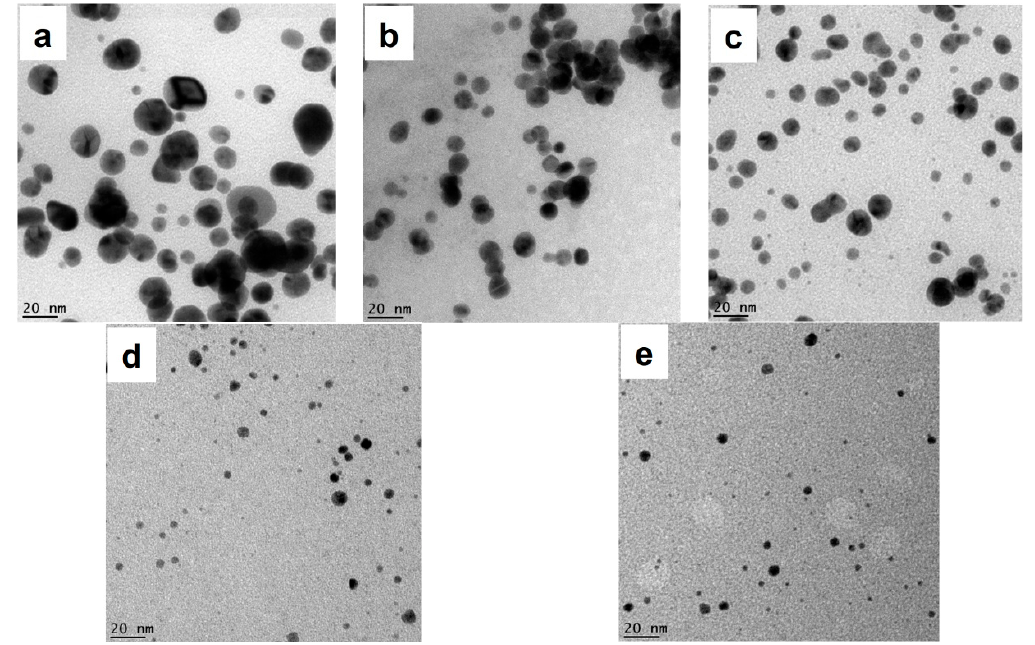
Figure 3. TEM images of AuNPs formed in C. sinensis peel extract at different pHs adjusted before the reaction: ( a ) pH = 3 (control); ( b ) pH = 6; ( c ) pH = 8; ( d ) pH = 10; ( e ) pH = 11.